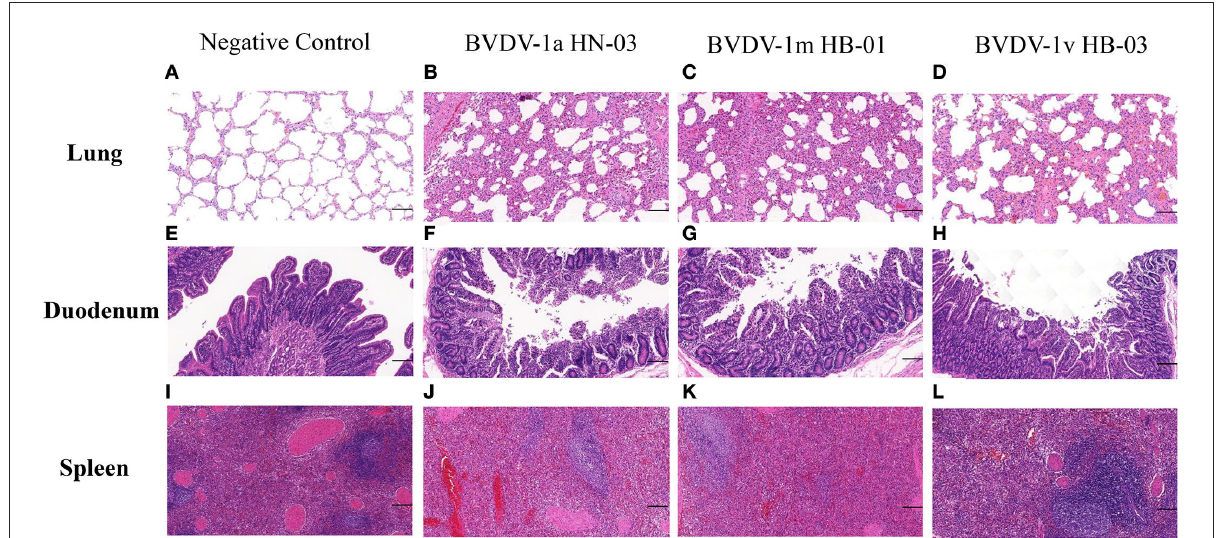
FIGURE9 Histopathological changes of lung, duodenum, and spleen. (A–L) Represent groups of the negative control, BVDV-1a HN-03, BVDV-1m HB-01, and BVDV-1v HB-03, respectively. Compared with the normal tissue structure (A) , the alveolar structure of calves infected with bovine viral diarrhea virus (BVDV) was destroyed (B–D) . Compared with the normal duodenal tissues (E) , the duodenum of the calves infected with bovine viral diarrhea virus (BVDV) (F–H) had a large amount of small intestinal chorion shed in the intestine. Compared with the normal spleen tissues (I) , the spleen of the calves infected with BVDV (J,K) showed a significantly wide periarterial lymphatic sheath, with increased bleeding points and lymphocytes depletion in red pulp. The horizontal line on the bottom right of each figure is the scale bar (100 µ m